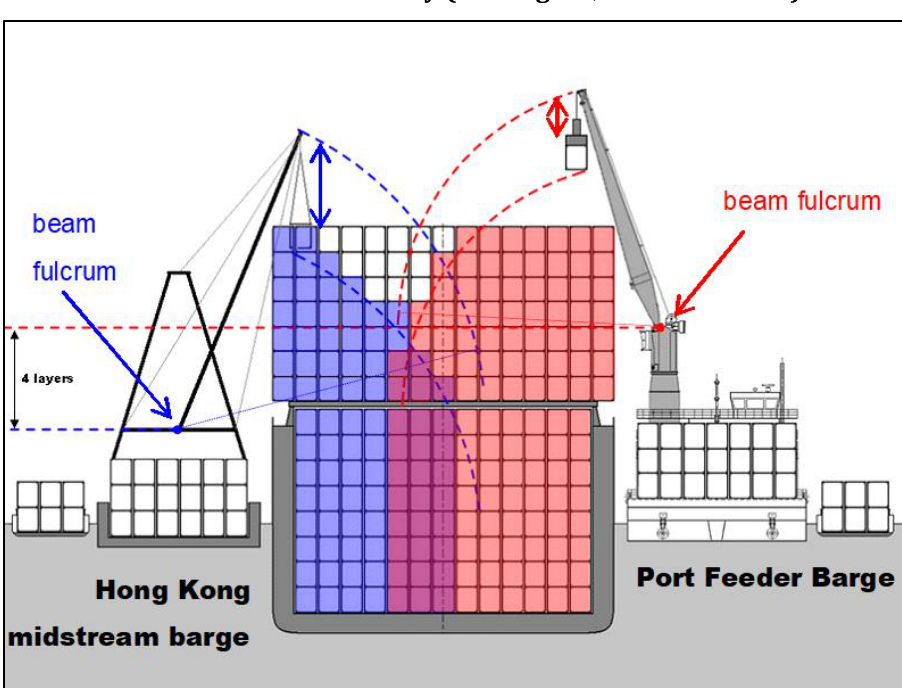
Figure 8: Hong Kong midstream barge vs. Port Feeder Barge - Vertical Slot Accessibility (serving a 6,000 TEU